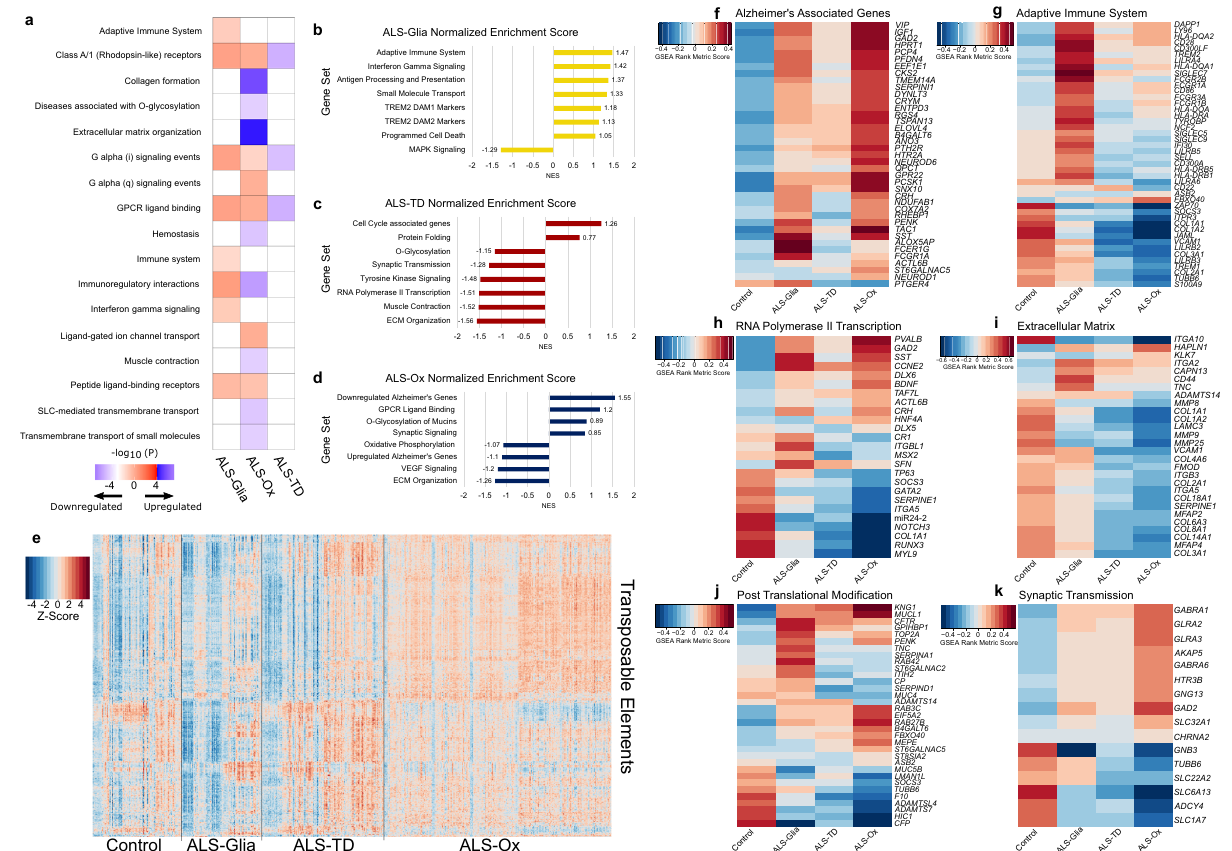
Fig. 2 | Enrichment analysis identi fi es subtype-speci fi c disease pathways. a Benjamini-Hochberg adjusted p -values, derived from a Fisher ’ s exact test, are presented on the – log 10 scale. All presented pathways are signi fi cantly enriched in atleastonesubtype.Negativeenrichmentisencodedasthenegativemagnitudeof the – log 10 (adjusted p -value). P , Fisher ’ s exact test, one-tailed, Benjamini-Hochberg methodformultiplehypothesistestcorrection. b – d GenesetsenrichedineachALS subtype are presented along the Y-axis, with GSEA normalized enrichment score (NES) presented along the X-axis. e Heatmap of transposable element expression,